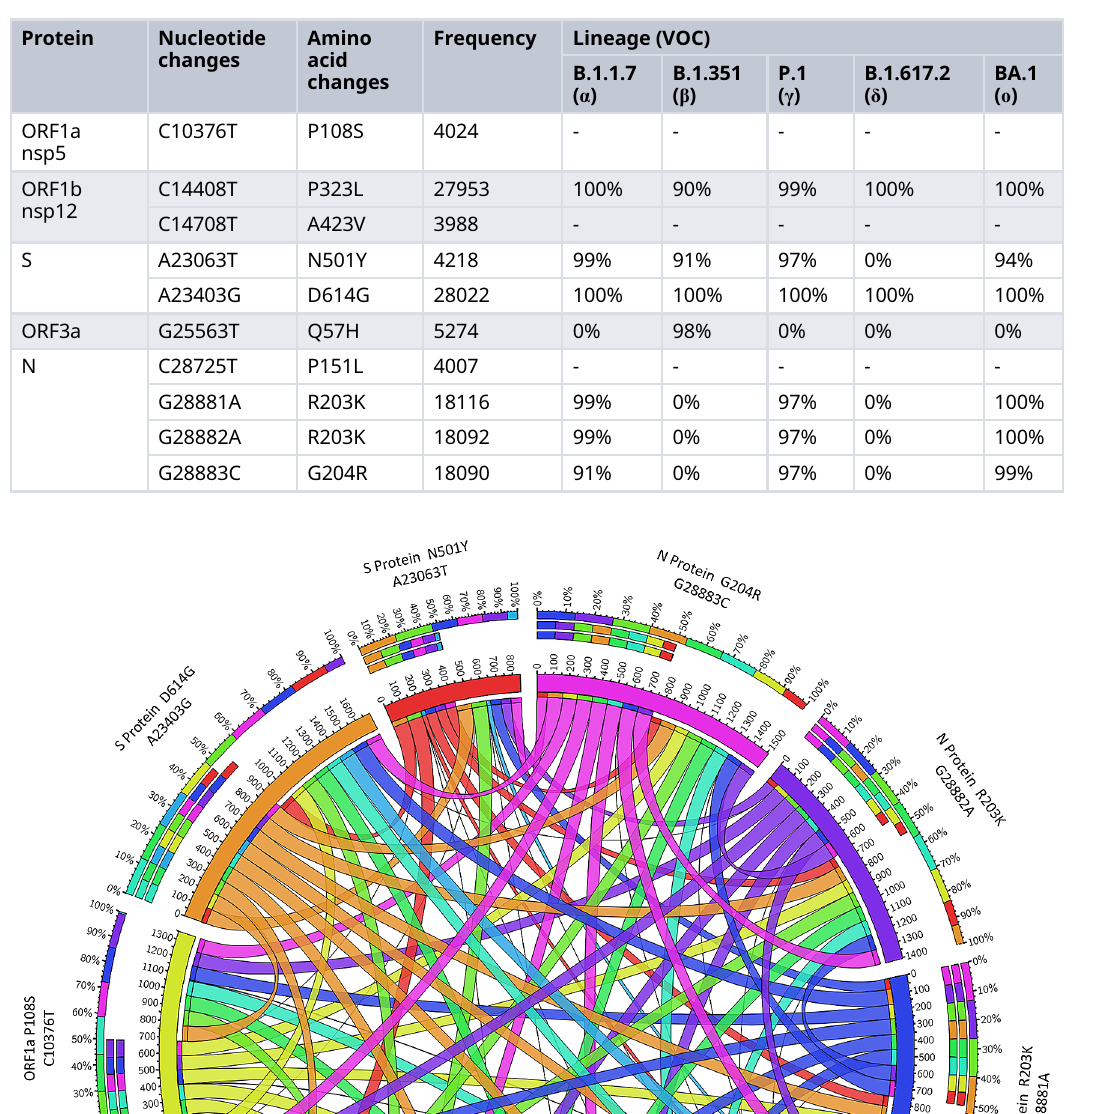
Table 3. Top 10 nonsynonymous mutations of SARS-CoV-2 proteins and their frequency percentage in the primary lineages of VOCs.